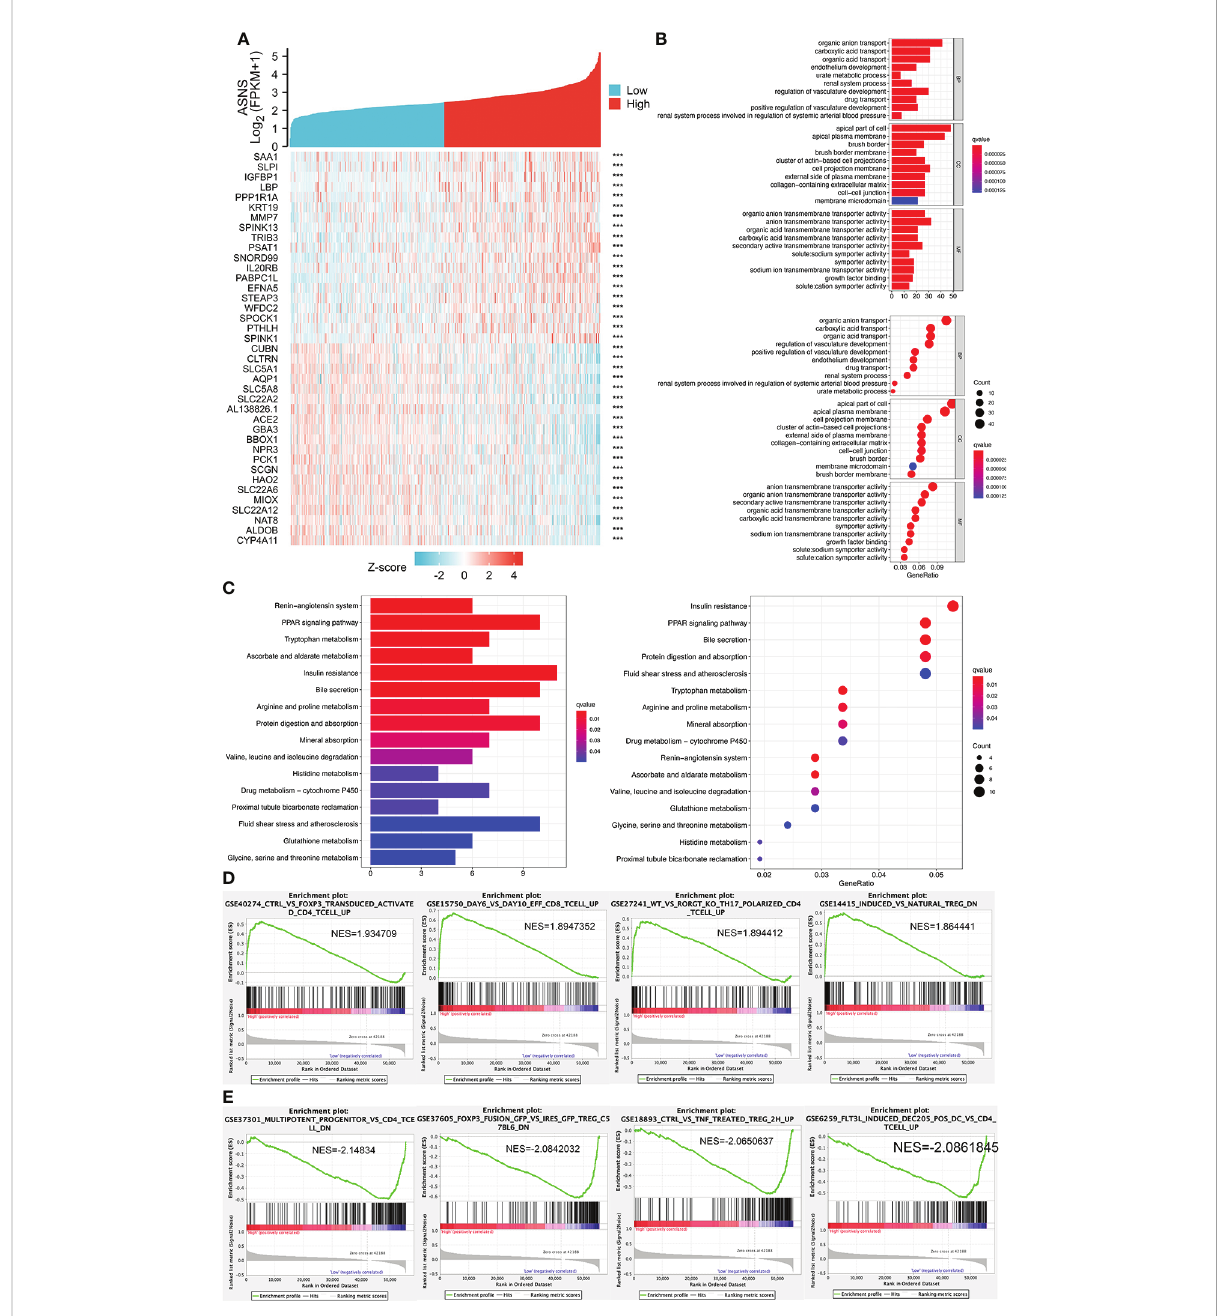
FIGURE 6 Cell function and pathway analysis involved in ASNS . (A) Heatmap of the expression patterns of the top 20 positively and negatively correlated genes of ASNS in ccRCC. (B) GO enrichment analysis. (C) KEGG enrichment analysis. (D, E) Gene set enrichment analysis